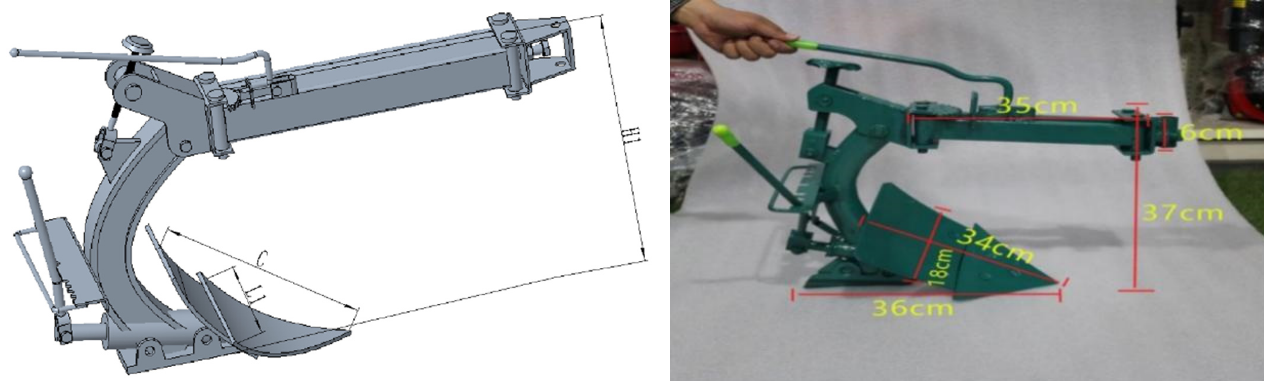
Figure 1. Overall dimension drawing of the double ‐ sided turning plough ditching device.